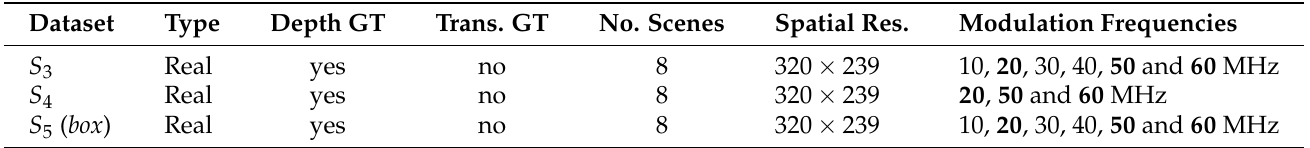
Table 2. Properties of the real-world datasets S 3 , S 4 and S 5 . In this work we only used the data relating to the frequencies marked in